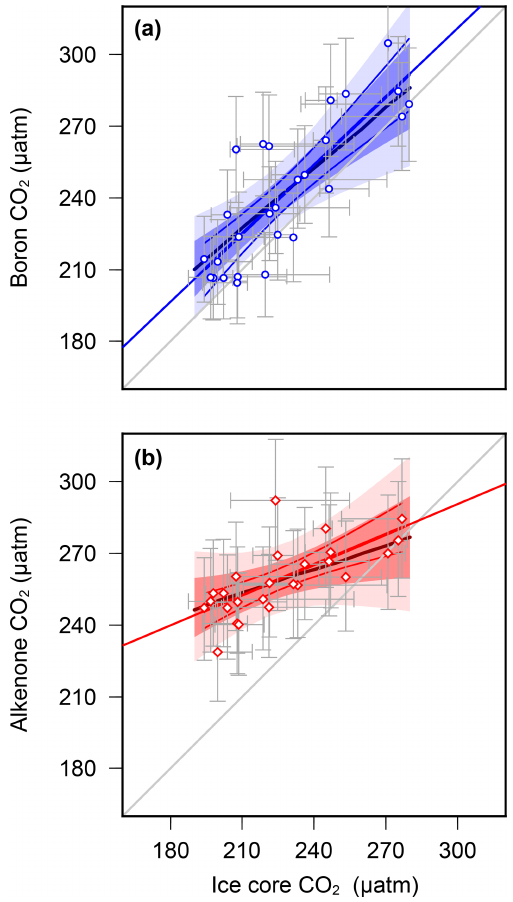
Figure 5. Regression analyses of proxy-based p CO 2 with ice core data (a) CO (Chalk et al., 2017) and (b) CO 2( ε vs. 2( δ 11 Bplank) p − alk) ice core data (Bereiter et al., 2015 and Table 1) for MIS5–8, inter- polated in the age domain. Regression lines (in red/blue) are linear fits with 68% and 95% confidence intervals, calculated by boot- strapping the uncertainties in proxy p CO 2 (Monte Carlo method described in the methods section). Uncertainty in the ice core val- ues is by estimated by applying a 3000 uncertainty in the age model during interpolation. Uncertainty envelopes considering data points alone (no bootstrap) are solid lines, with p max regressions in the thicker, darker colours. A 1 : 1 line is shown in grey for compar- ison. Statistical calculations were performed in R (R Core Team,